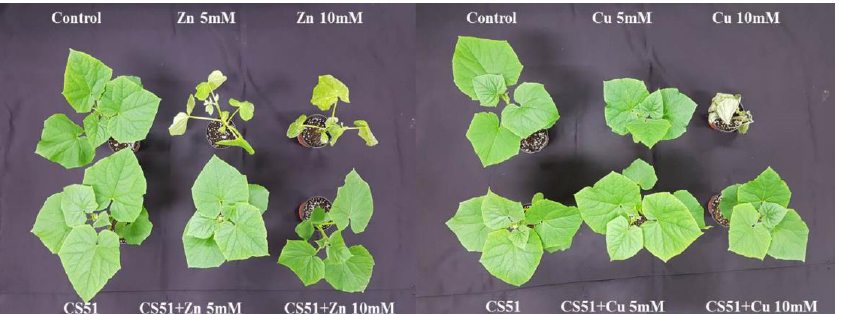
Figure 2. Effect of CS51 on the growth of cucumber plant, under control conditions, copper (5 mM and 10 mM Cu) and zinc (5 mM and 10 mM Zn) stress. Control, untreated plants; CS51, P. psychrotolerans -treated; Cu 5 mM and Cu 10 mM, copper treated plants; Zn 5 mM and Zn 10 mM, zinc treated plants; Cu 5 mM and Cu 10 mM + CS51, copper + CS51-treated plants; Zn 5 mM and Zn 10 mM + CS51, zinc + CS51-treated plants.